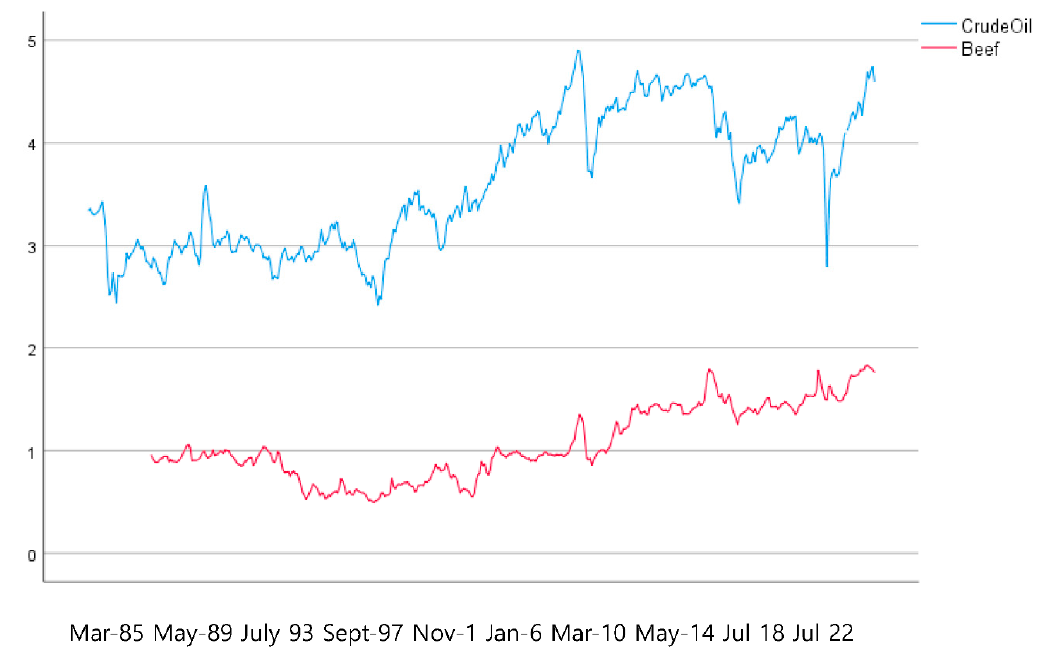
Figure 8. Time-Series (Logarithmic) Plot of Crude Oil and Beef Price Patterns.